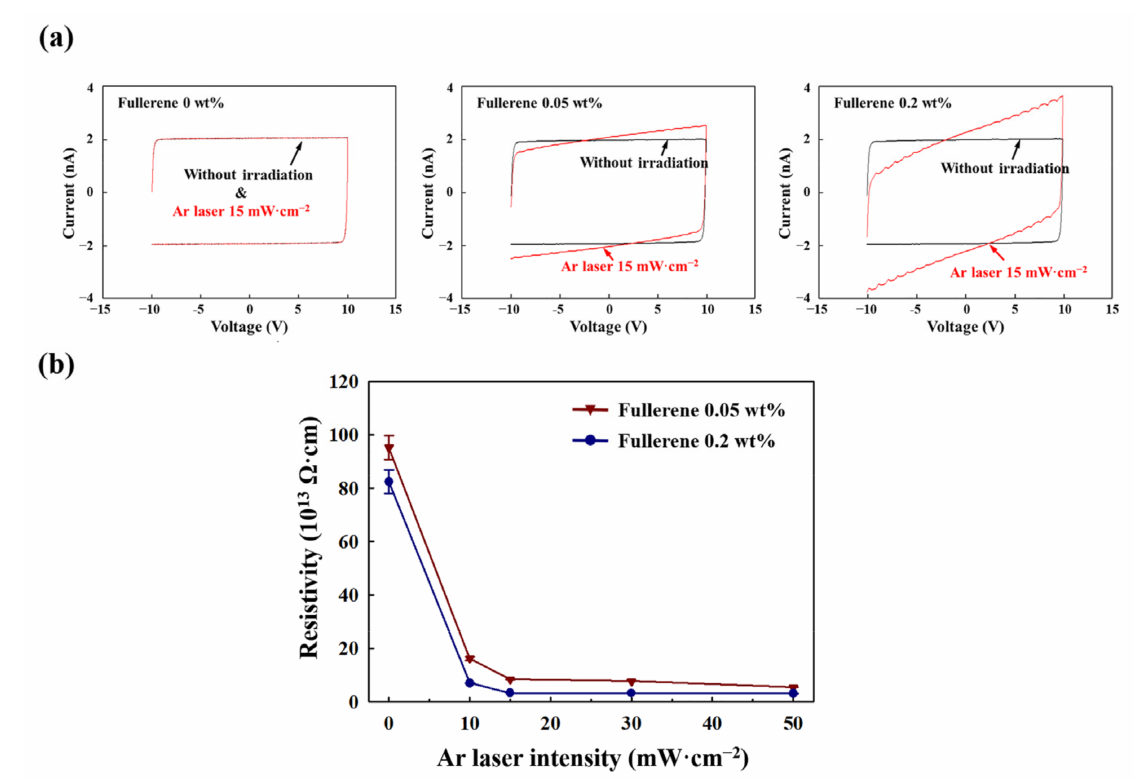
Figure 4. ( a ) Current ( I ) curves of fullerene-doped high- ρ ( ρ ~ 10 15 Ω · cm without optical excitation) LC alignment PI layers obtained by applied voltage ( V ) sweeps according to the fullerene doping concentration, where the V – I properties are measured without and with the photoinduced charge generations of fullerene nanoparticles by controlling the Ar laser irradiation (15 mW · cm − 2 ). ( b ) Photocontrolled resistivity values of fullerene-doped high- ρ LC alignment PI layers according to the Ar laser intensity and fullerene doping